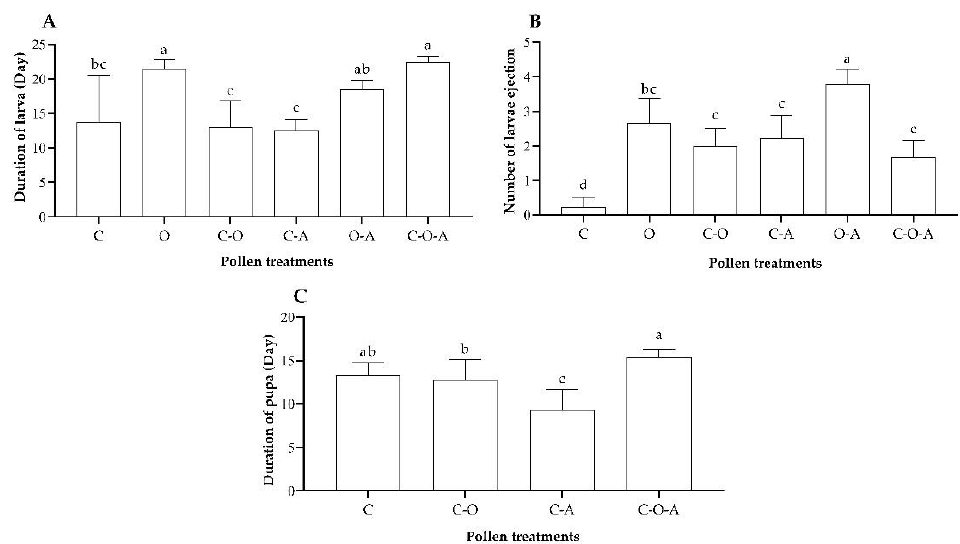
Figure 4. Parameters for the development of larvae and pupae of each pollen treatment: ( A ) duration of larval development; ( B ) number of larvae ejected; ( C ) duration of pupal development. C: camellia pollen mix; O: oilseed rape pollen mix; C – O: camellia – oilseed rape pollen mix; C – A: camellia – apricot pollen mix; O – A: oilseed rape – apricot pollen mix; C – O – A: camellia – oilseed rape – apricot pollen mix. The data having same letter represents with no differences among treatments ( p > 0.05), and the data having different letter represents with have significant differences among treatments ( p < 0.05).